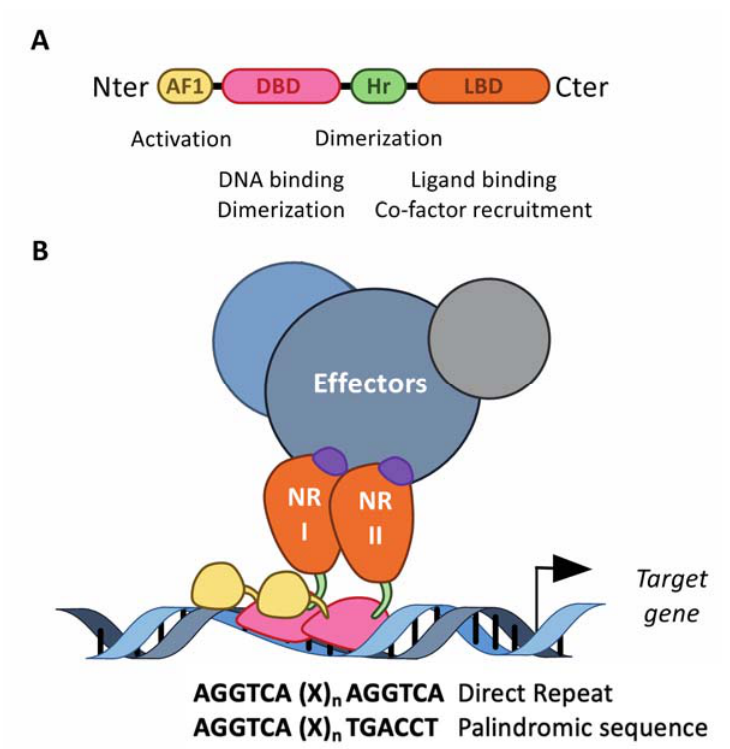
Figure 2. The structure of the nuclear receptors. ( A ) NRs consist of modular domains, including a variable amino N-terminal activation domain (AF-1), a highly conserved DNA-binding domain (DBD) and a conserved hinge region linking the DBD with the conserved ligand-binding domain (LBD). The DBD mediates the specific recruitment of NRs monomers, homodimers and heterodimers to their DNA response element and is involved in the dimerization of NRs with their partner, together with the hinge region and the LBD. ( B ) NRs usually work as homo- or heterodimers, which bind to a specific response element composed of two AGGTCA half-sites separated by one to four nucleotides in the promoter of target genes. These half-sites are organized either as a palindromic sequence or a direct repeat. The LBD mediates ligand-dependent interactions with effectors, namely transcriptional co-activators or co-repressors. These interactions are controlled by ligand-dependent conformational changes in the LBD. In absence of a ligand, co-repressors are preferentially bound to NRs, whereas ligand binding induces a conformational, which then triggers the release of co-repressors, allowing co-activators to bind.